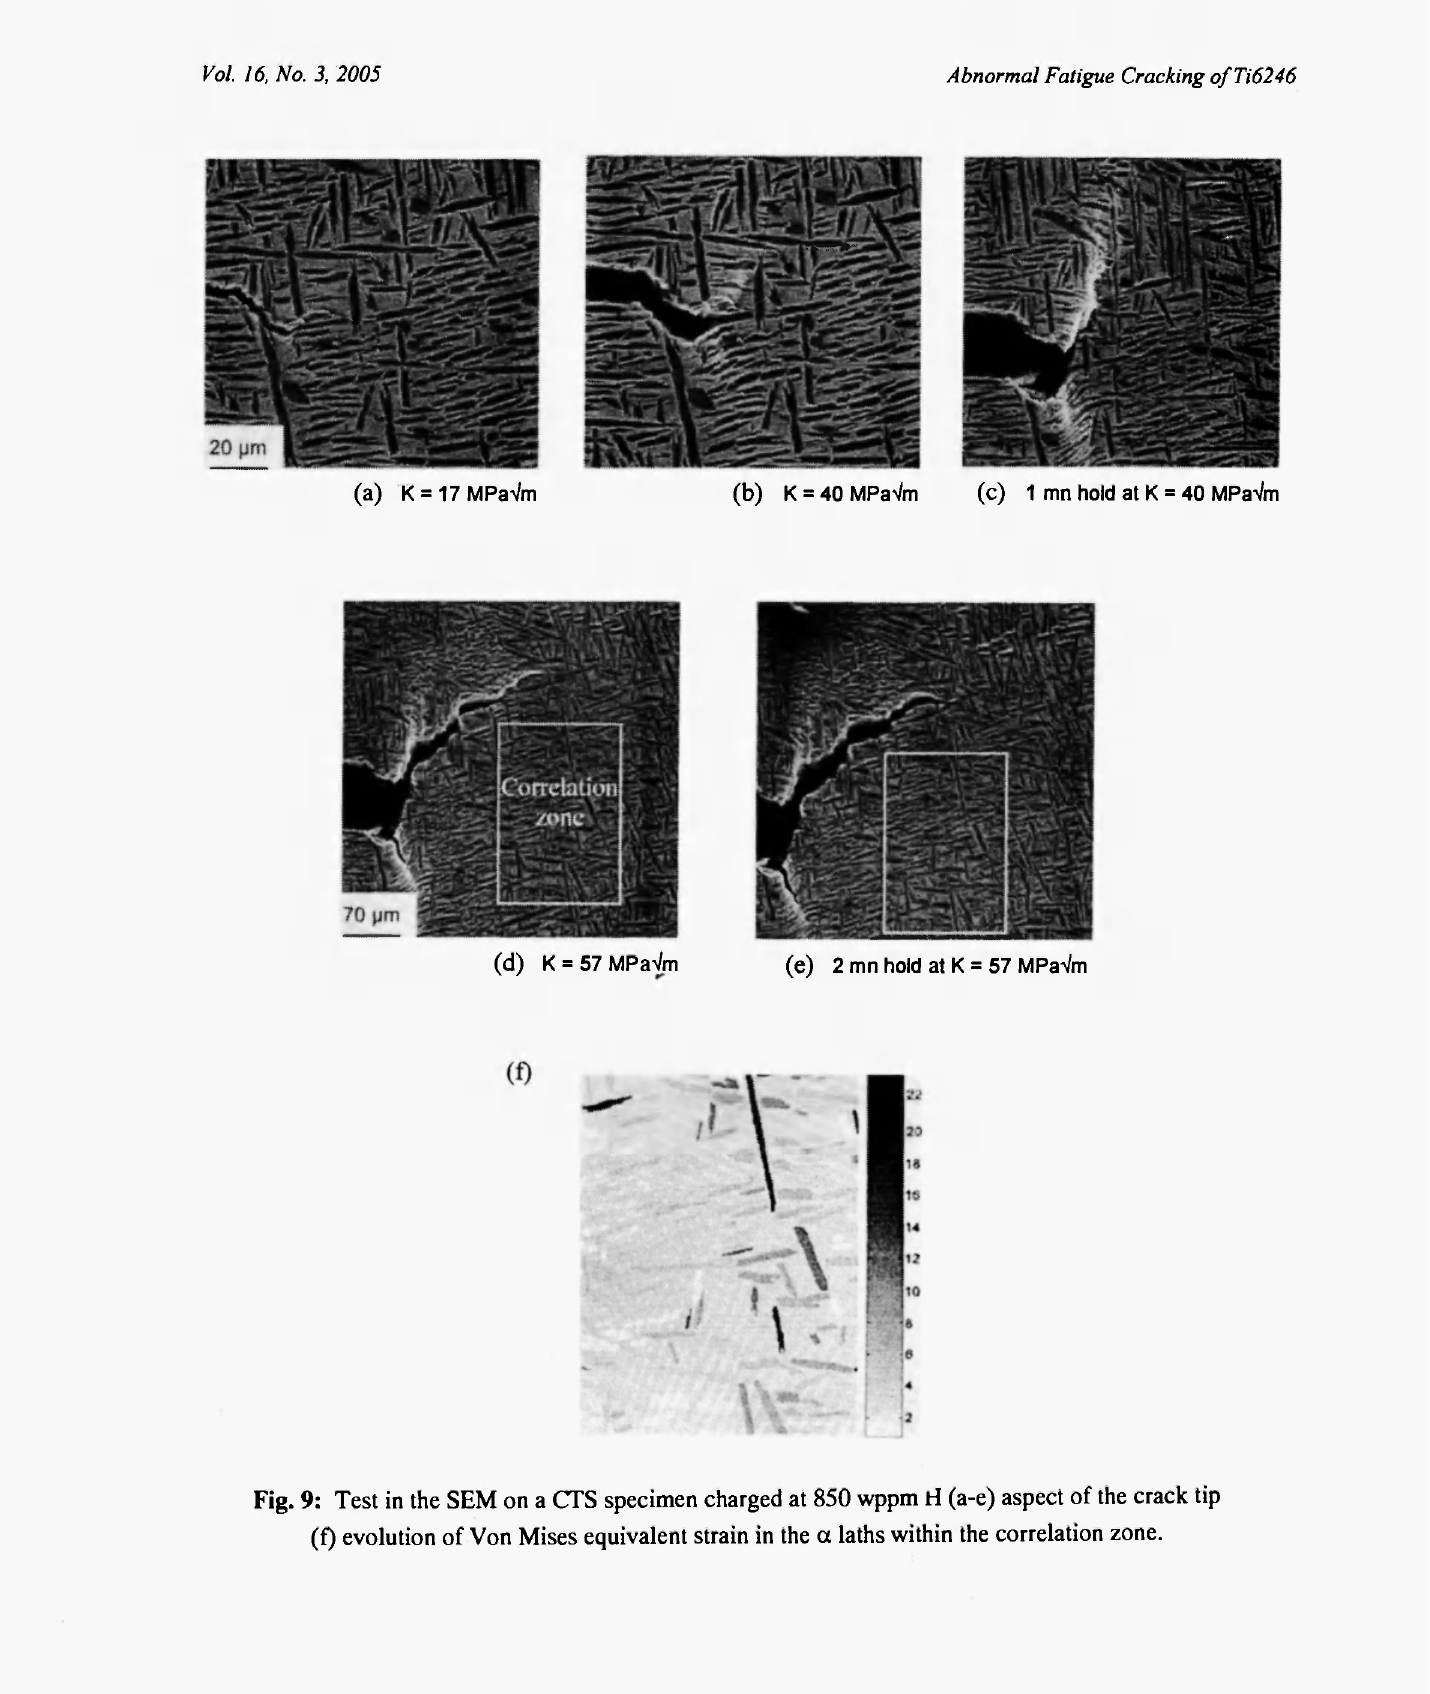
Fig. 9: Test in the SEM on a CTS specimen charged at 850 wppm ri (a-e) aspect of the crack tip (f) evolution of Von Mises equivalent strain in the a laths within the correlation